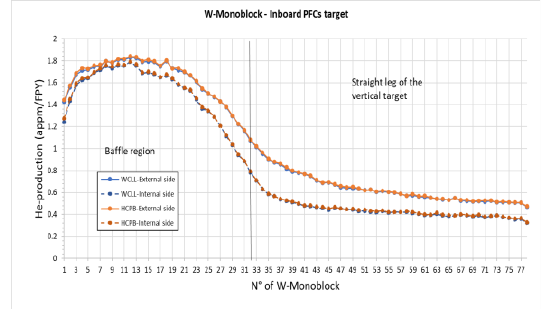
Figure 36. Inner poloidal profiles of the He-production (appm/FPY) on W-Monoblocks, comparing the values on the external and the innermost target sides, both for WCLL and HCPB blanket case.